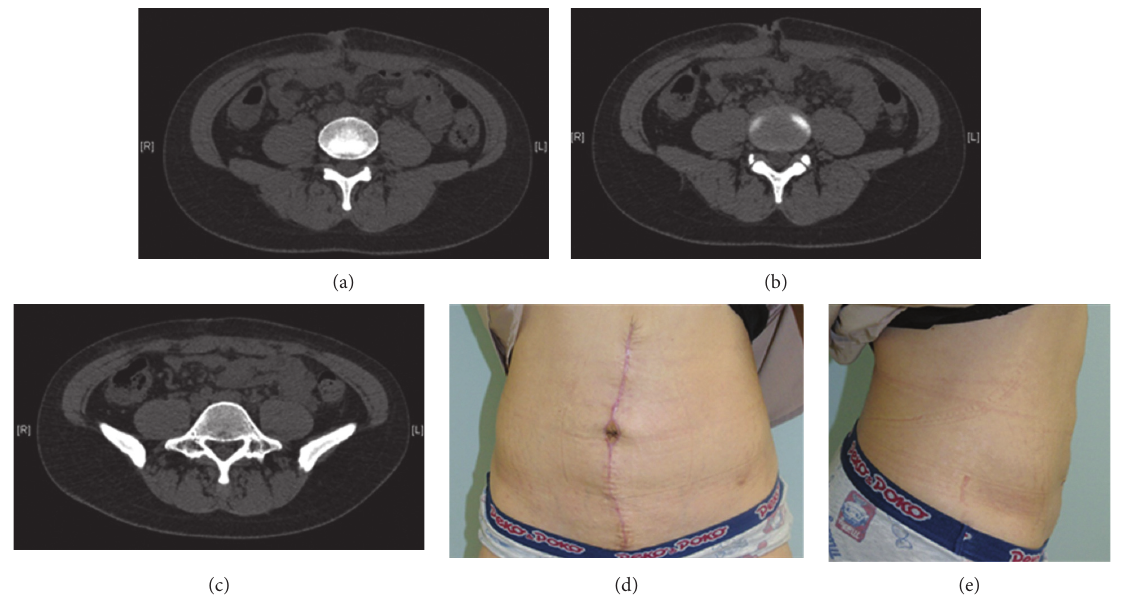
Figure 4: (a–c) Postoperative abdominal computed tomography. (a) 3 cm above the superior border of the umbilicus; (b) center of the umbilicus; (c) 2cm below the inferior border of the umbilicus. There is no apparent recurrence of the hernia. (d-e) Appearance three months after surgery. The patient’s abdominal bulge has